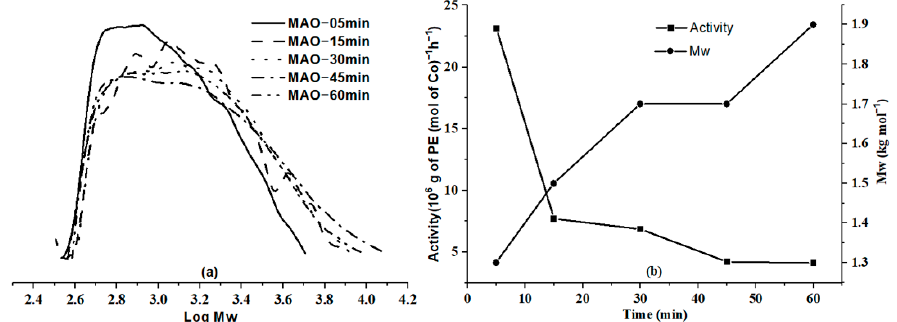
Figure 5. For Co6 /MAO: ( a ) GPC traces of the polyethylene obtained at different reaction times; and ( b ) plots of catalytic activity and M w of the resultant PE as a function of reaction time (entries 3, 12–15, Table 2).